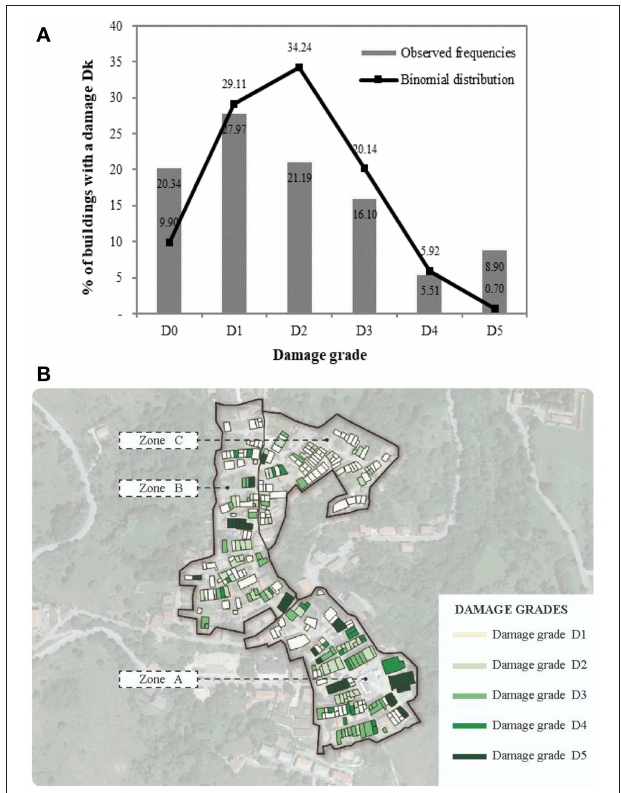
FIGURE 8 | Observed damage scenario. (A) Damage Probability Matrix and Binomial Distribution for the historic center of Campotosto. (B) GIS representation of the Damage spatial distribution (on a Google Earth Map).